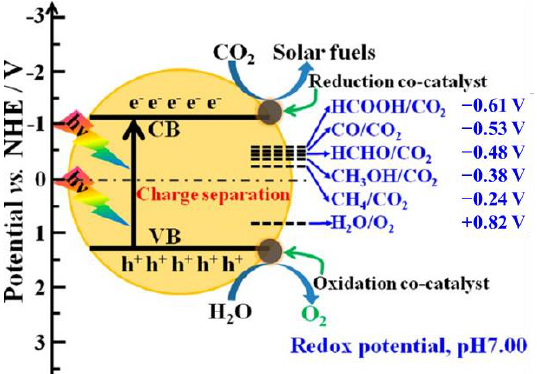
Figure 8. Schematic of the photocatalytic reduction of CO 2 by semiconductor materials. Reprinted with permission from Ref. [100]. 2016 Li, K.; Peng, B.; Peng, T.